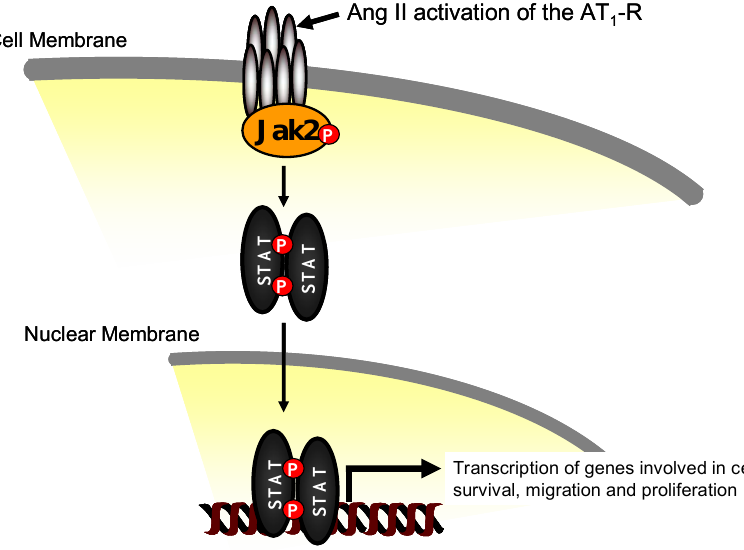
Ang II activation of the AT